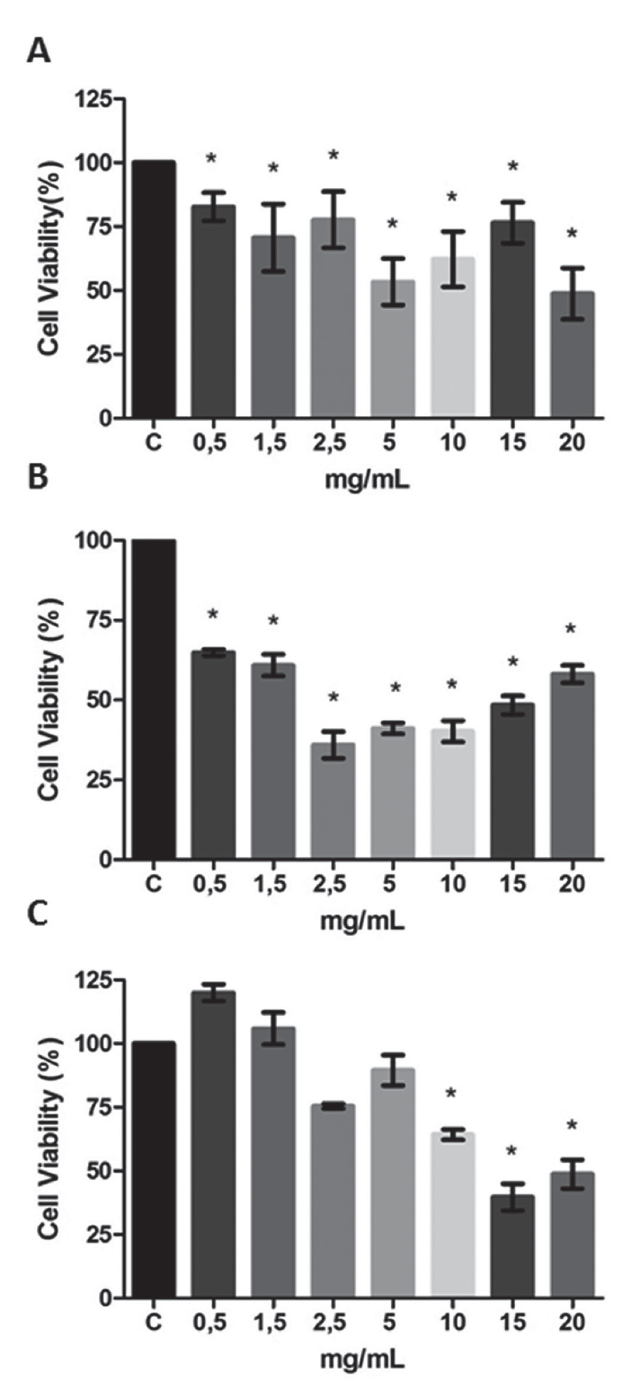
FIGURE 1 - Effects of treatment with different concentrations of E. uniflora aqueous crude extract in relation to the viability of cervical carcinoma cells (SiHa) for 24 hours (A), 48 hours (B) and 72 hours (C). Data show mean and standard deviation of 3 independent experiments performed in triplicate. * P <0.05 (One-way ANOVA followed by Tukey’s